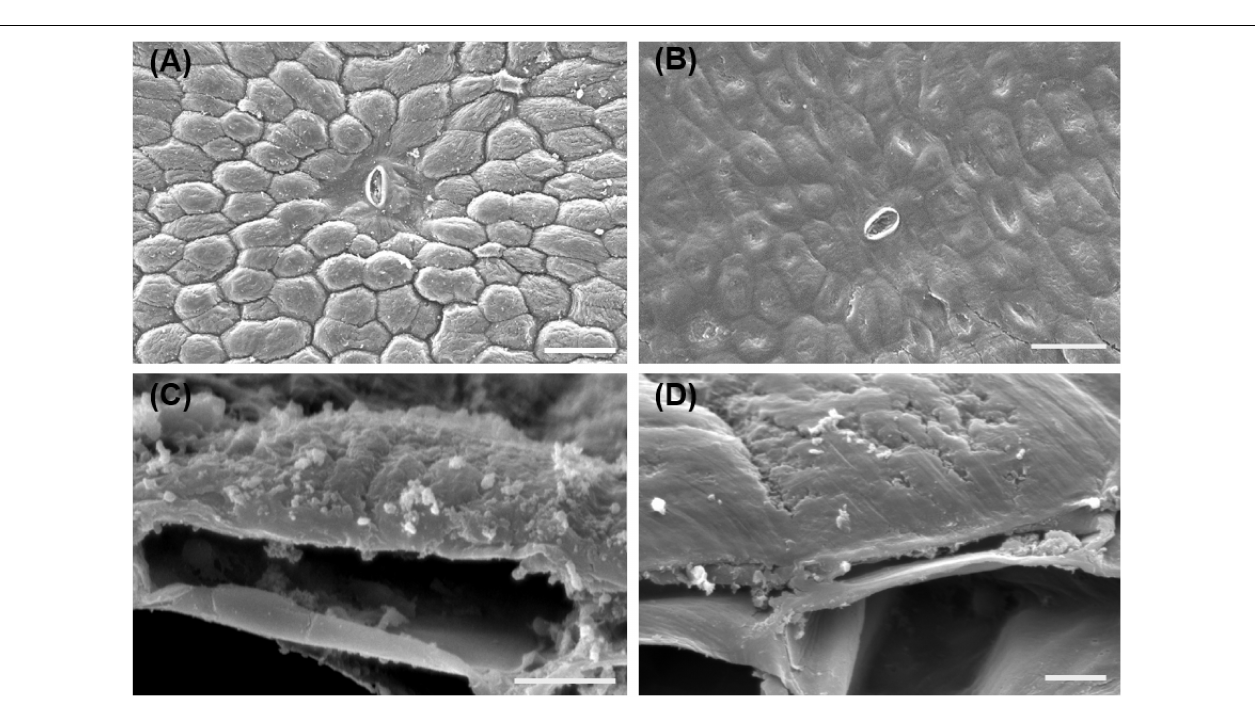
FIGURE 1 | Changes of chilling injury of banana fruit under low temperature. (A) Appearance of fruit stored at 4 and 25 ◦ C for 6 days, and obvious browning occurred in banana at 4 ◦ C. (B) Chilling index indicated by browning area of fruit under low and room temperature at 6 days. (C) Changes in hue angle values following the storage time under different temperature storage. Data are presented as the mean ± SD. Significant differences detected by the t -test are indicated by * p < 0.05 and ** p < 0.01, respectively.